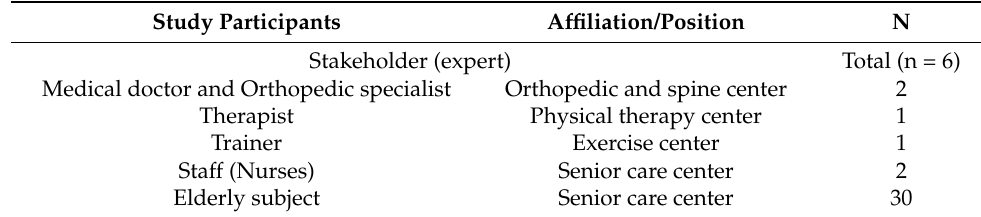
Table 1. Stakeholders’ information.